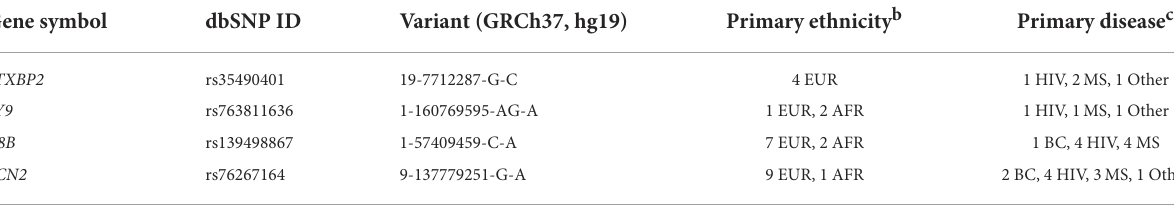
TABLE 6 Distribution of genotype-positive PML cases a across ethnicities and primary diseases. Gene symbol dbSNP ID Variant (GRCh37, hg19) Primary ethnicity